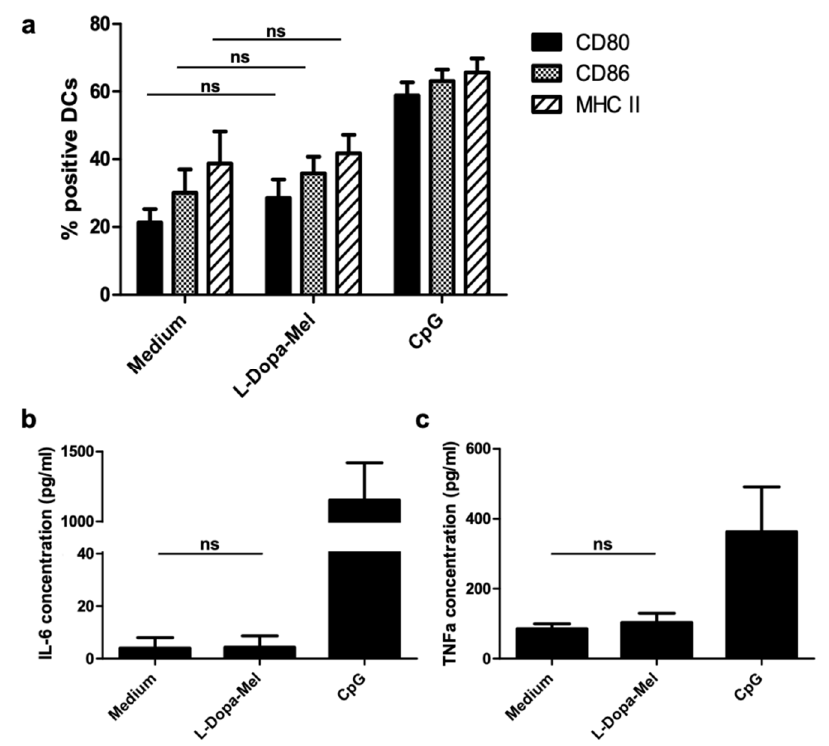
Figure 5. Effects of L-DOPA-melanin on dendritic cells. Cells derived from the bone marrow of C47-Bl6 mice were cultivated with GM-CSF (granulocyte-macrophage colony-stimulating factor) at 20 ng/mL for 8 days and then non-adhering cells incubated with L-DOPA melanin at 4 µg/mL or CpG at 1 µg/mL (positive control; 5 ′ -TAAACGTTATAACGTTATGACGTCAT, Oligovax, Paris, France) or medium alone (negative control) for 24 h (5 × 10 5 cells/mL). Cells were then analyzed by flow cytometry ( a ) and supernatant by ELISA ( b , c ). ( a ) After incubation with anti-mouse CD16/32 (clone 93, Biolegend) and Amcyan LIVE/DEAD Fixable Aqua Dead Cell Stain Kit (Invitrogen) at room temperature for 15 min, cells were stained with anti-mouse CD11c PC (clone N418, Biolegend), CD80 FITC (clone 16–10A1, eBioscience), CD86 PE-Cy7 (clone GL − 1, Biolegend), and major histocompatibility complex class II (MHC II) PE (clone NIMR − 4, eBioscience). The graph shows the percentage of CD80-, CD86- and MHC II-positive cells among CD11c+ cells. ( b , c ) The amount of proinflammatory cytokines (B: interleukin 6, IL-6; C: tumor necrosis factor alpha, TNF-a) in the cell culture supernatants was determined by ELISA. Data from 3 independent experiments with triplicates as mean ± SEM; statistical analysis was performed with Mann–Whitney test; ns: non-significant ( p > 0.05) (data from our lab). APC: antigen-presenting cell; DC: dendritic cell. Other melanin-like nanoparticles have been proposed as cancer vaccine